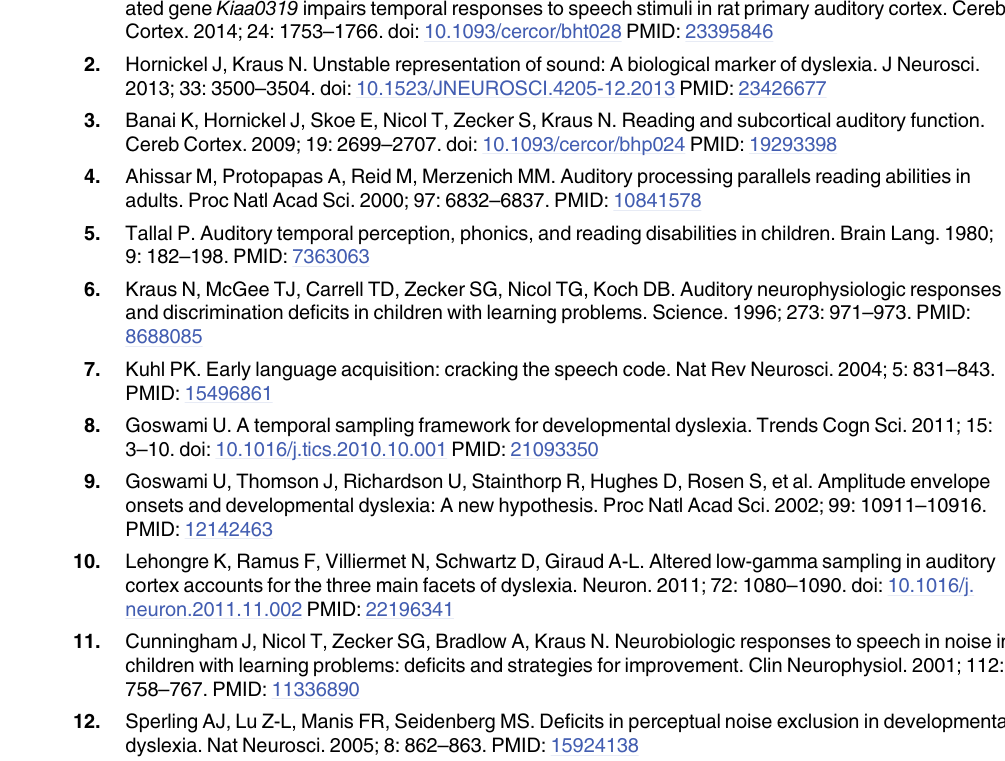
S1 Text. The cross-validation analysis from Experiment 1 is described. The cross-validation tested the generalizability of the regression